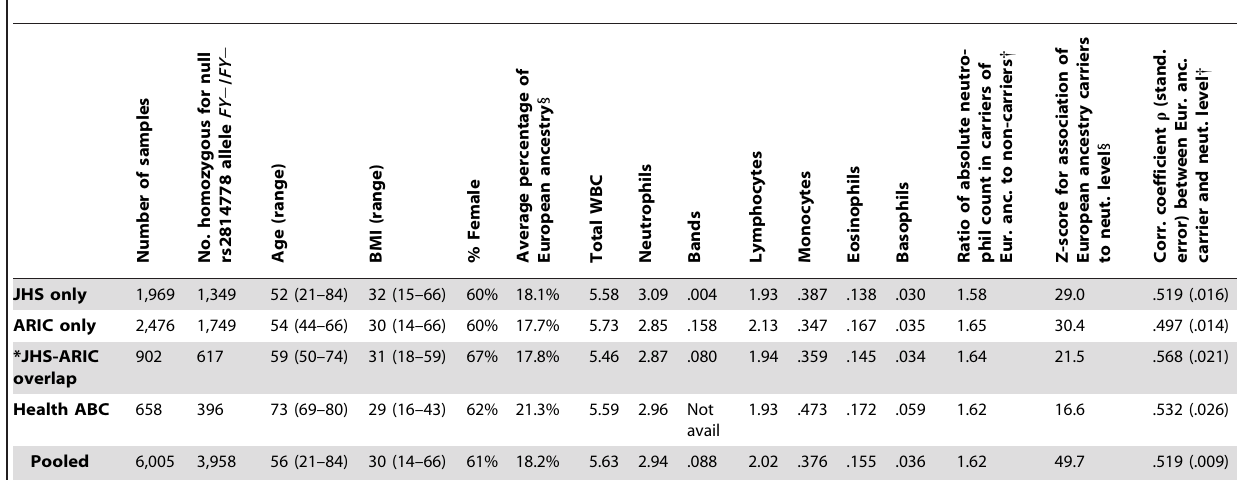
Table 1. Comparison of phenotypic characteristics for the four sets of samples used in this